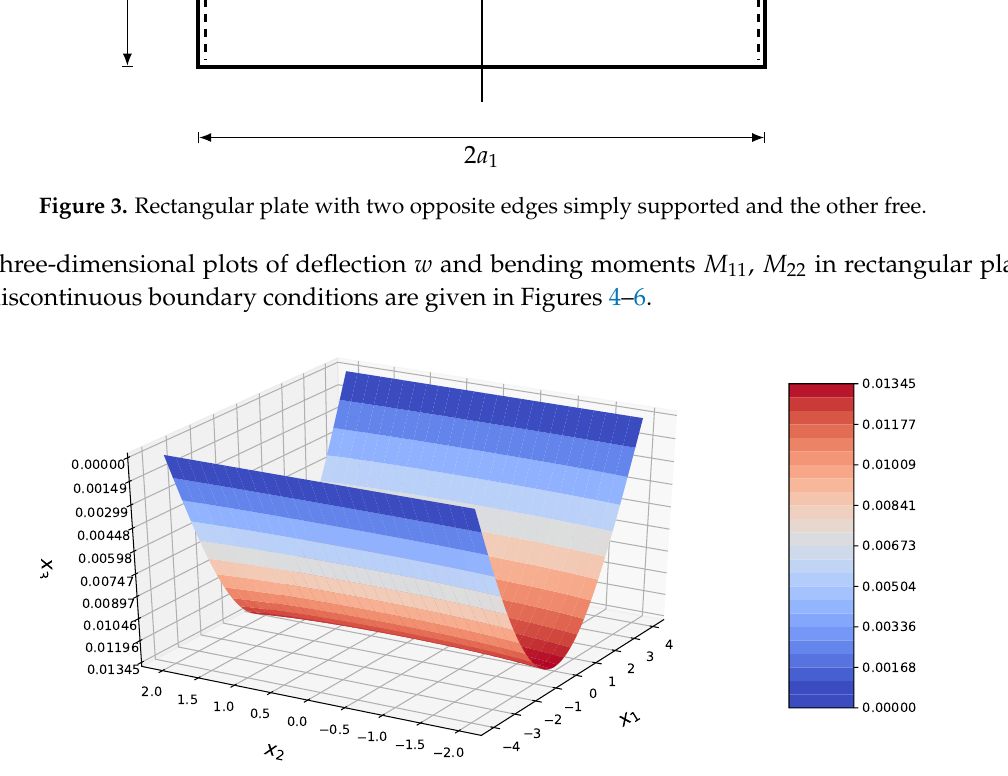
Figure 4. Three-dimensional plot of the deflection of a rectangular plate with two opposite edges simply supported and the other free.